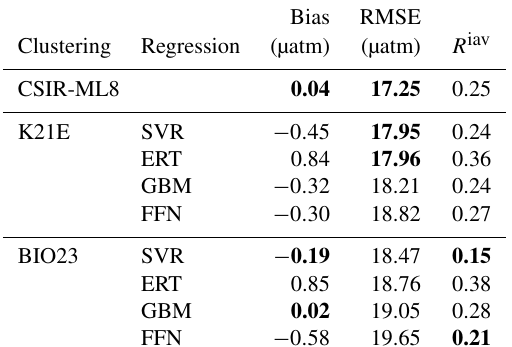
tures: SST, log 10 (MLD clim ), p CO clim , log 10 (Chl a clim ) and 2 Table 3. Regression scores for the CO 2 biomes (BIO23), the clus- tering configuration from column E in Fig. 5 (K21E) and the en- semble average (CSIR-ML8). Abbreviations are as follows: RMSE is the root mean square error; R iav is the relative interannual vari- ability (Eq. 5). Regression methods are as follows: SVR is sup- port vector regression; ERT is extremely randomised trees; GBM is the gradient-boosting machine; FFN is the feed-forward neural network. Bold values are significantly lower than the mean for that column ( p < 0 . 05 for the two-tailed Z test; absolute values are used for the bias